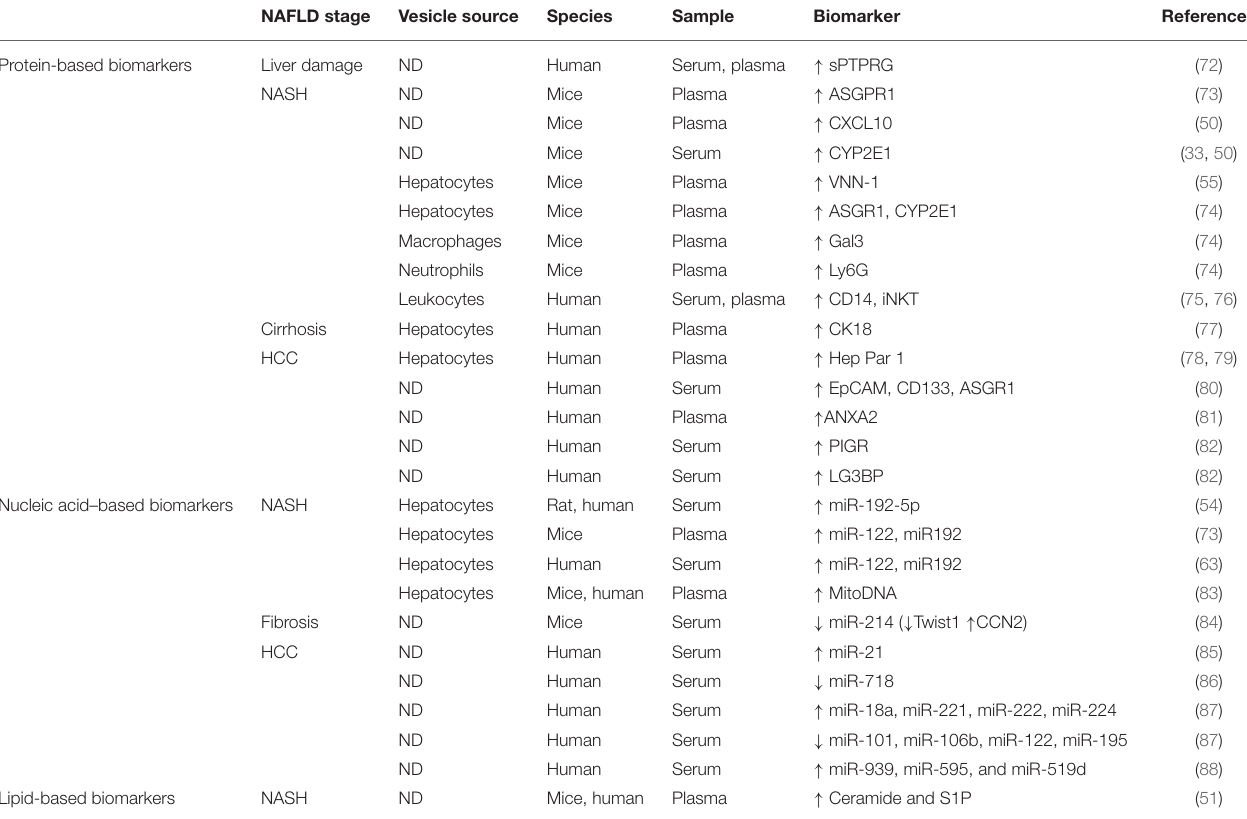
TABLE 1 | Extracellular vesicle biomarkers in nonalcoholic fatty liver disease